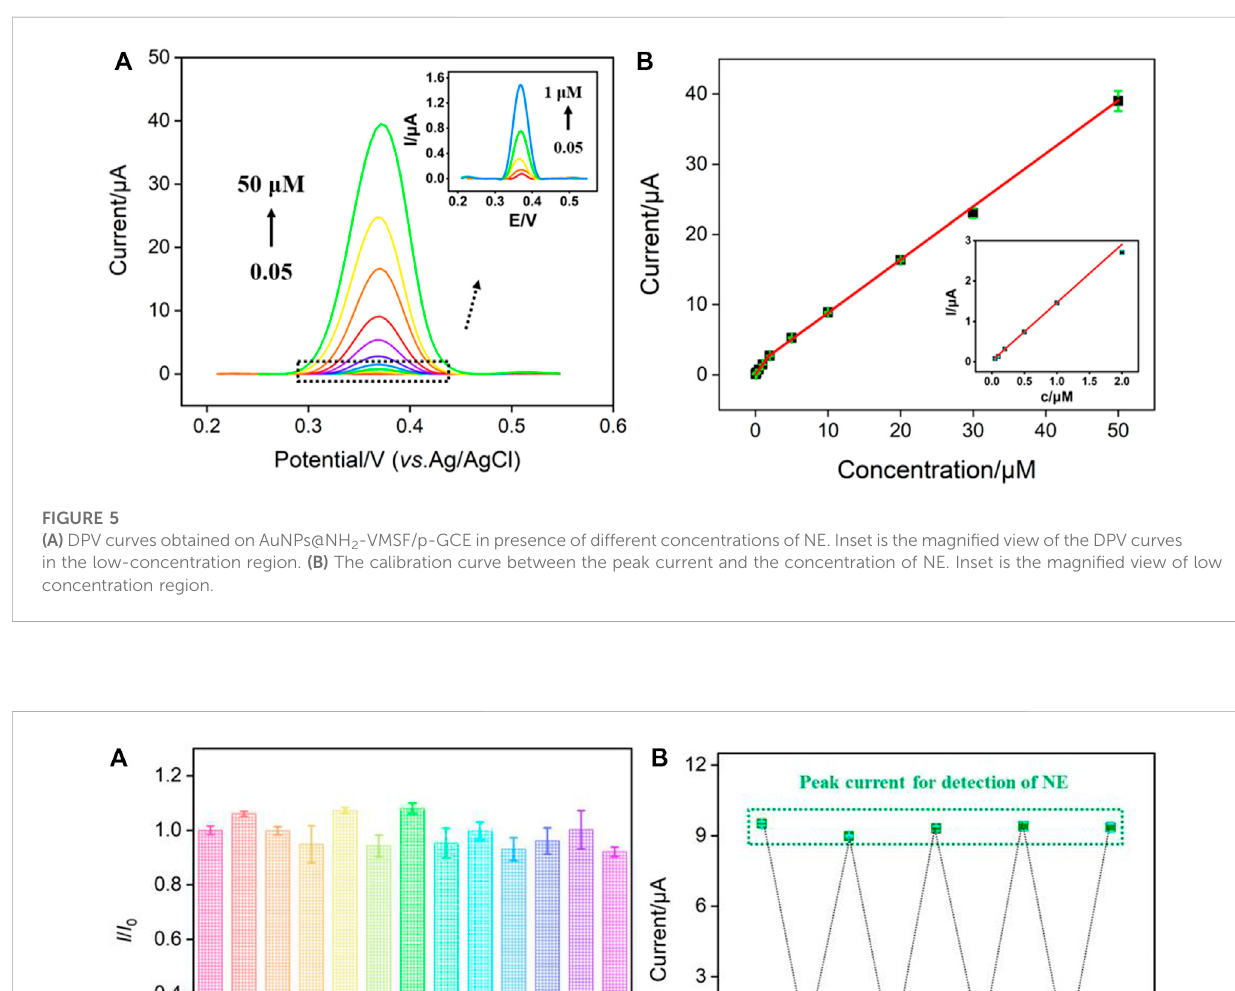
FIGURE 6 (A) The current ratio ( I / I 0 ) obtained on AuNPs@NH 2 -VMSF/p-GCE for detection of NE (5.0 Ca 2+ , Na + , Zn 2+ , AA, UA, FA, OA, Glu, Lcy) or 10 mg/mL of other added interfering species. (B) The peak current obtained on original or